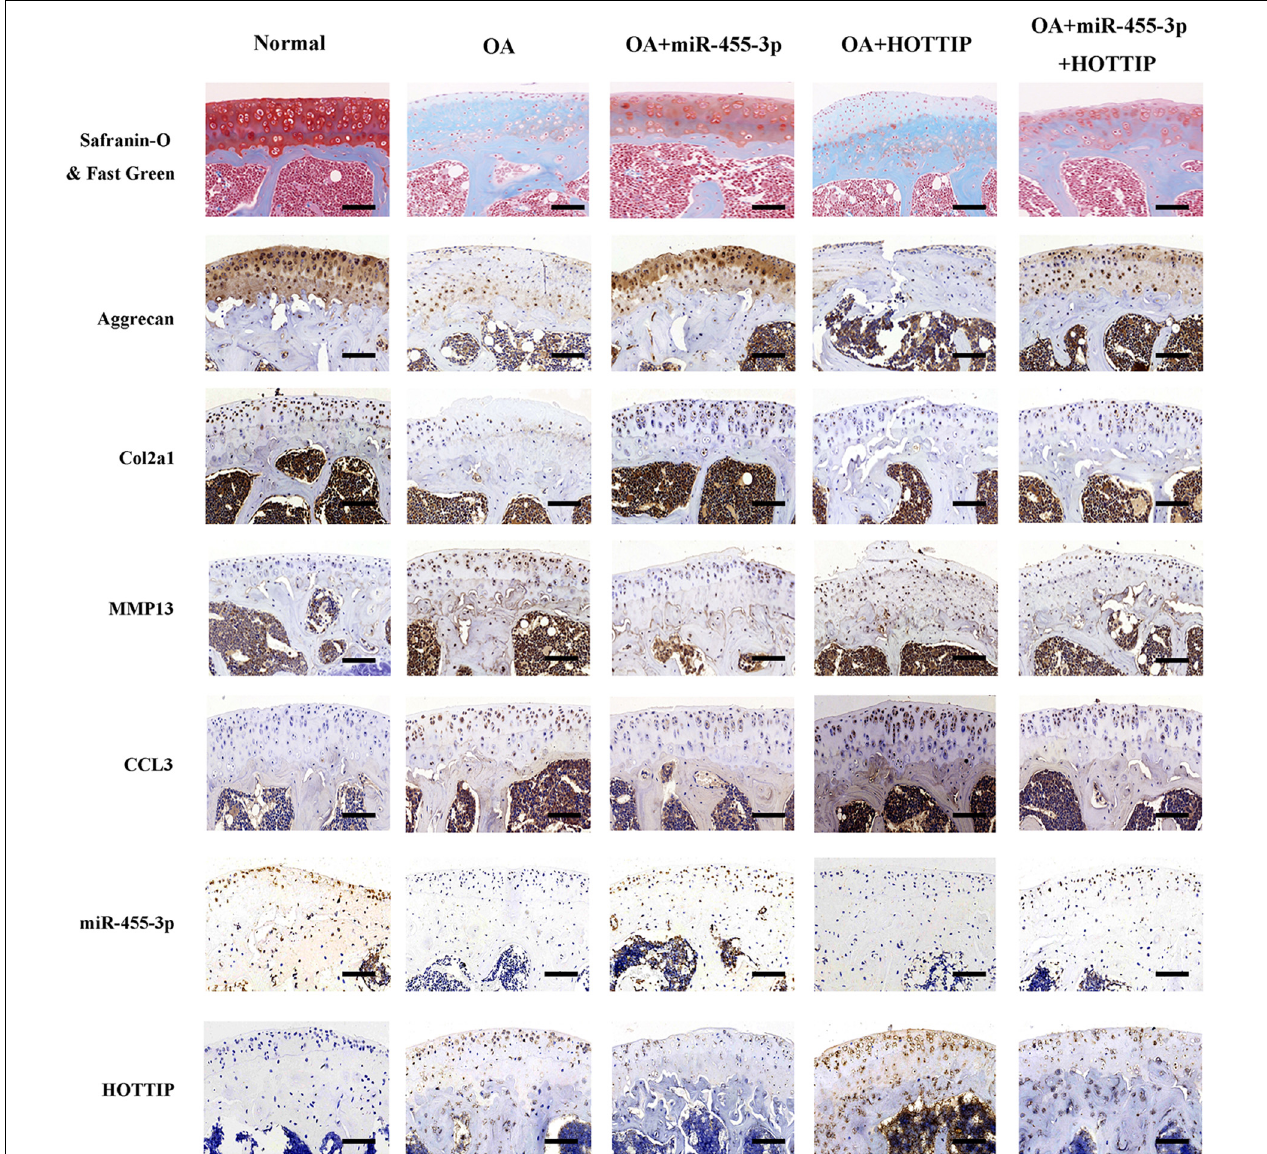
FIGURE 8 | miR-455-3p and lncRNA HOTTIP regulate the function of CCL3 in vivo . Sections of tibial plateau ( n = 10) were stained using Safranin-O/Fast Green immunohistochemistry (COL2A1, aggrecan, MMP13, and CCL3) and in situ hybridization (miR-455-3p and HOTTIP probe). Scale bar: 50 µ